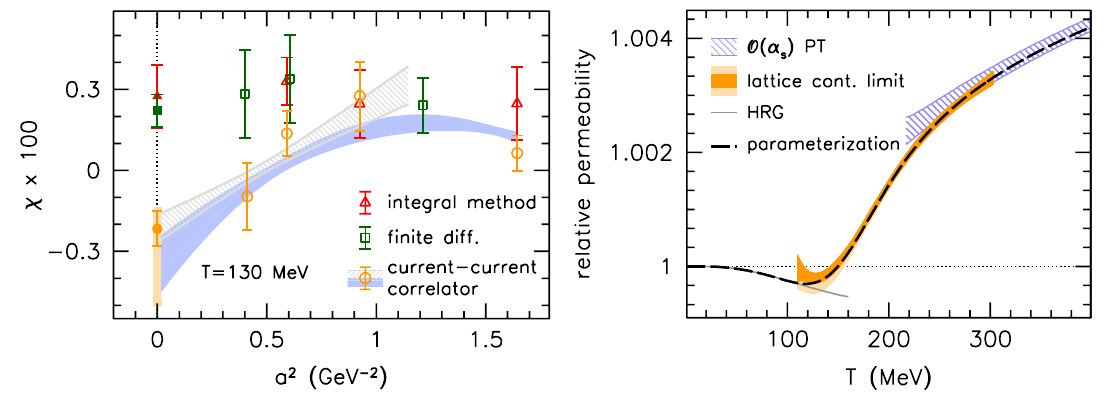
Figure 5 . Left panel: lattice discretization errors in the renormalized magnetic susceptibility. The results of ref. [47] (green) and those of ref. [28] (red) are compared to the present approach (yellow) including systematic uncertainties (light yellow). The dashed gray and the light blue bands represent the T = 130 MeV slices of the multi-spline (cid:12)t involving up to O ( a 2 ) and O ( a 4 ) lattice artefacts, respectively. Note that for the green points at a > 0, (cid:31) was obtained by temperature- interpolations of the results published in ref. [47]. Right panel: parametrization of the relative magnetic permeability (cid:22)=(cid:22) 0 = (1 (cid:0) e 2 (cid:31) ) (cid:0) 1 via the function (F.7) of appendix